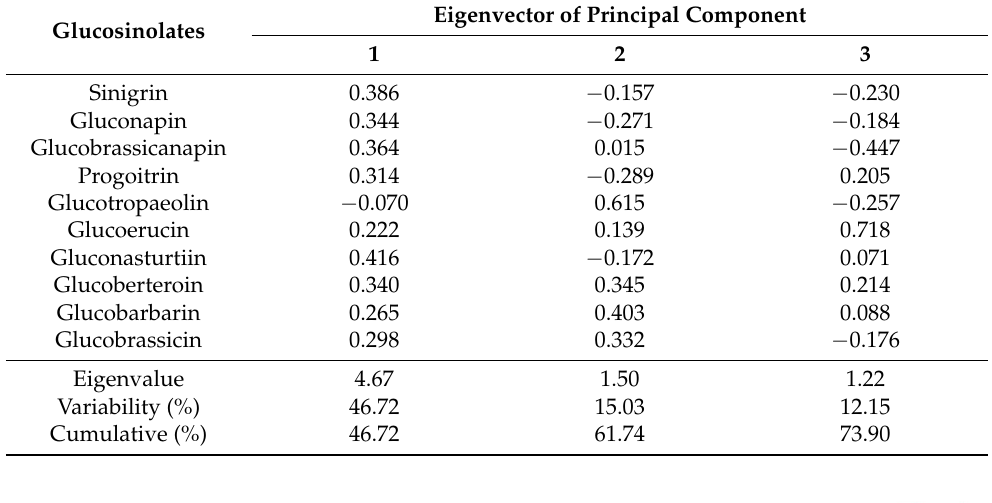
Figure 3. Results of principal components 1 (47.72%) and 2 (15.03%) with 60 germplasms based on ten glucosinolates. The score plots were represented by yellow, green, blue, and pink colors. The star shapes describe loading plots. Table 4. Three principal components among ten glucosinolates of 60 germplasms.